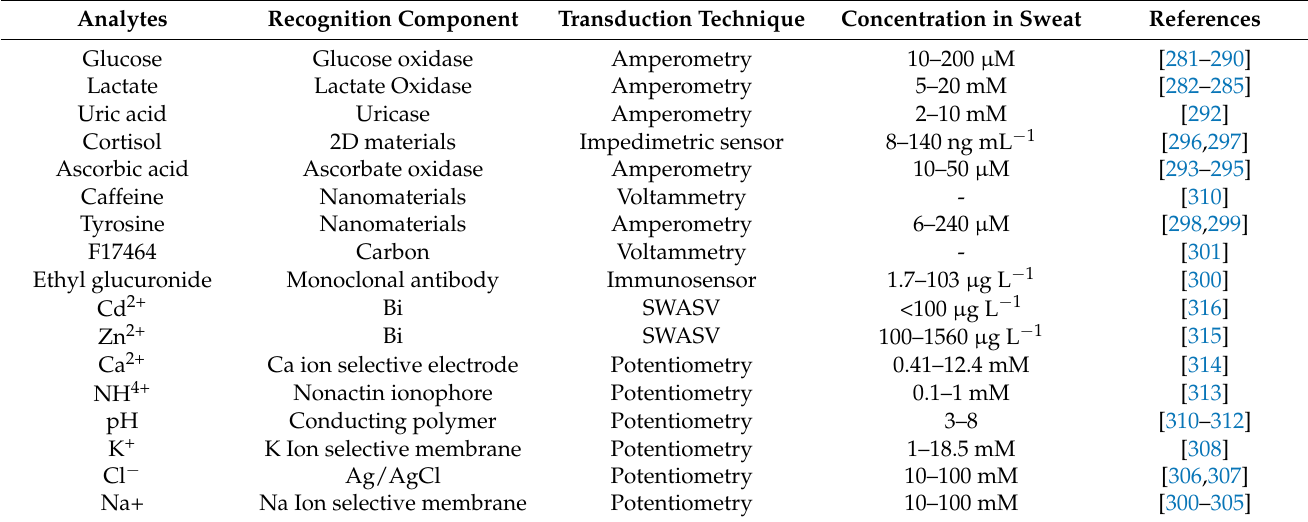
Table 4. Common detection techniques and sweat